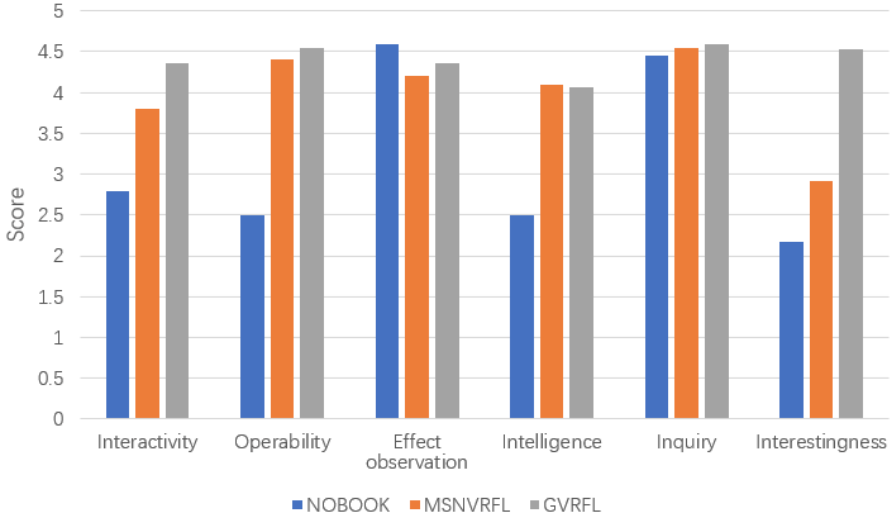
Figure 21. User ratings.